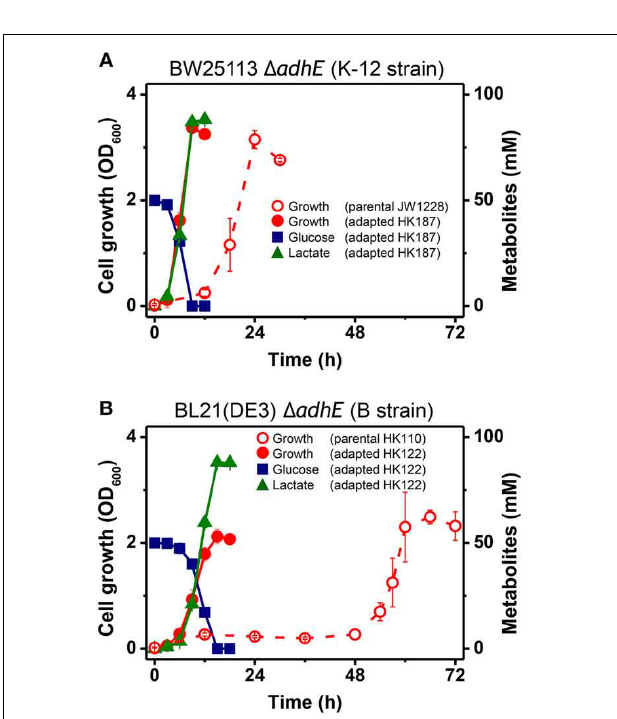
FIGURE 3 | Rapid anaerobic cellular growth of anaerobically-adapted E. coli K-12 (cid:2) adhE mutants (A) and B (cid:2) adhE mutants (B).